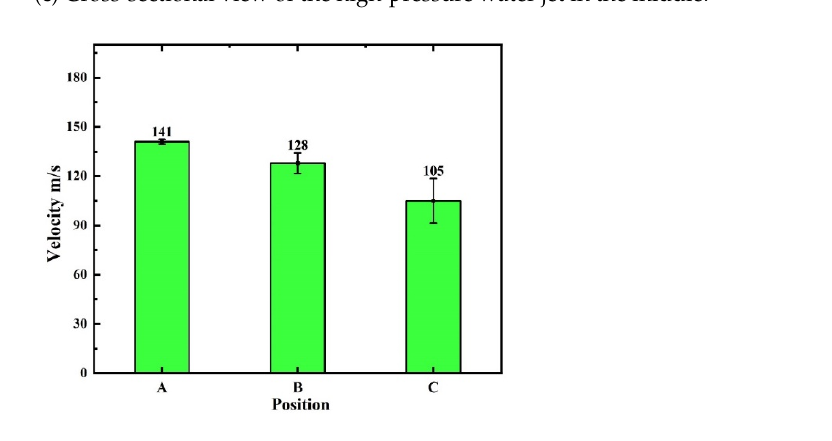
Figure 10. A schematic diagram of the velocity distribution of the high-pressure water jet at positions A, B, and C.